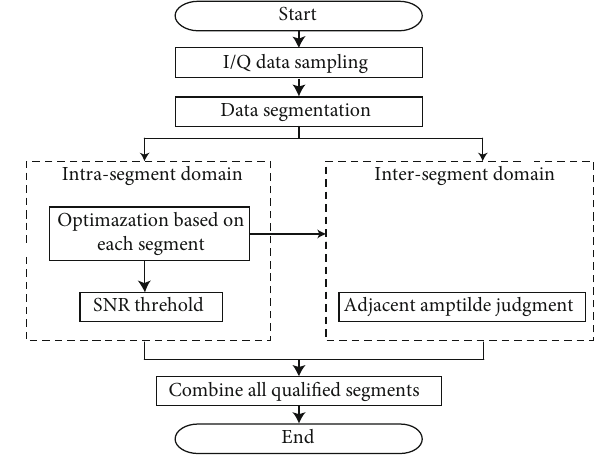
Figure 7: The fl owchart of adaptive anti-interference